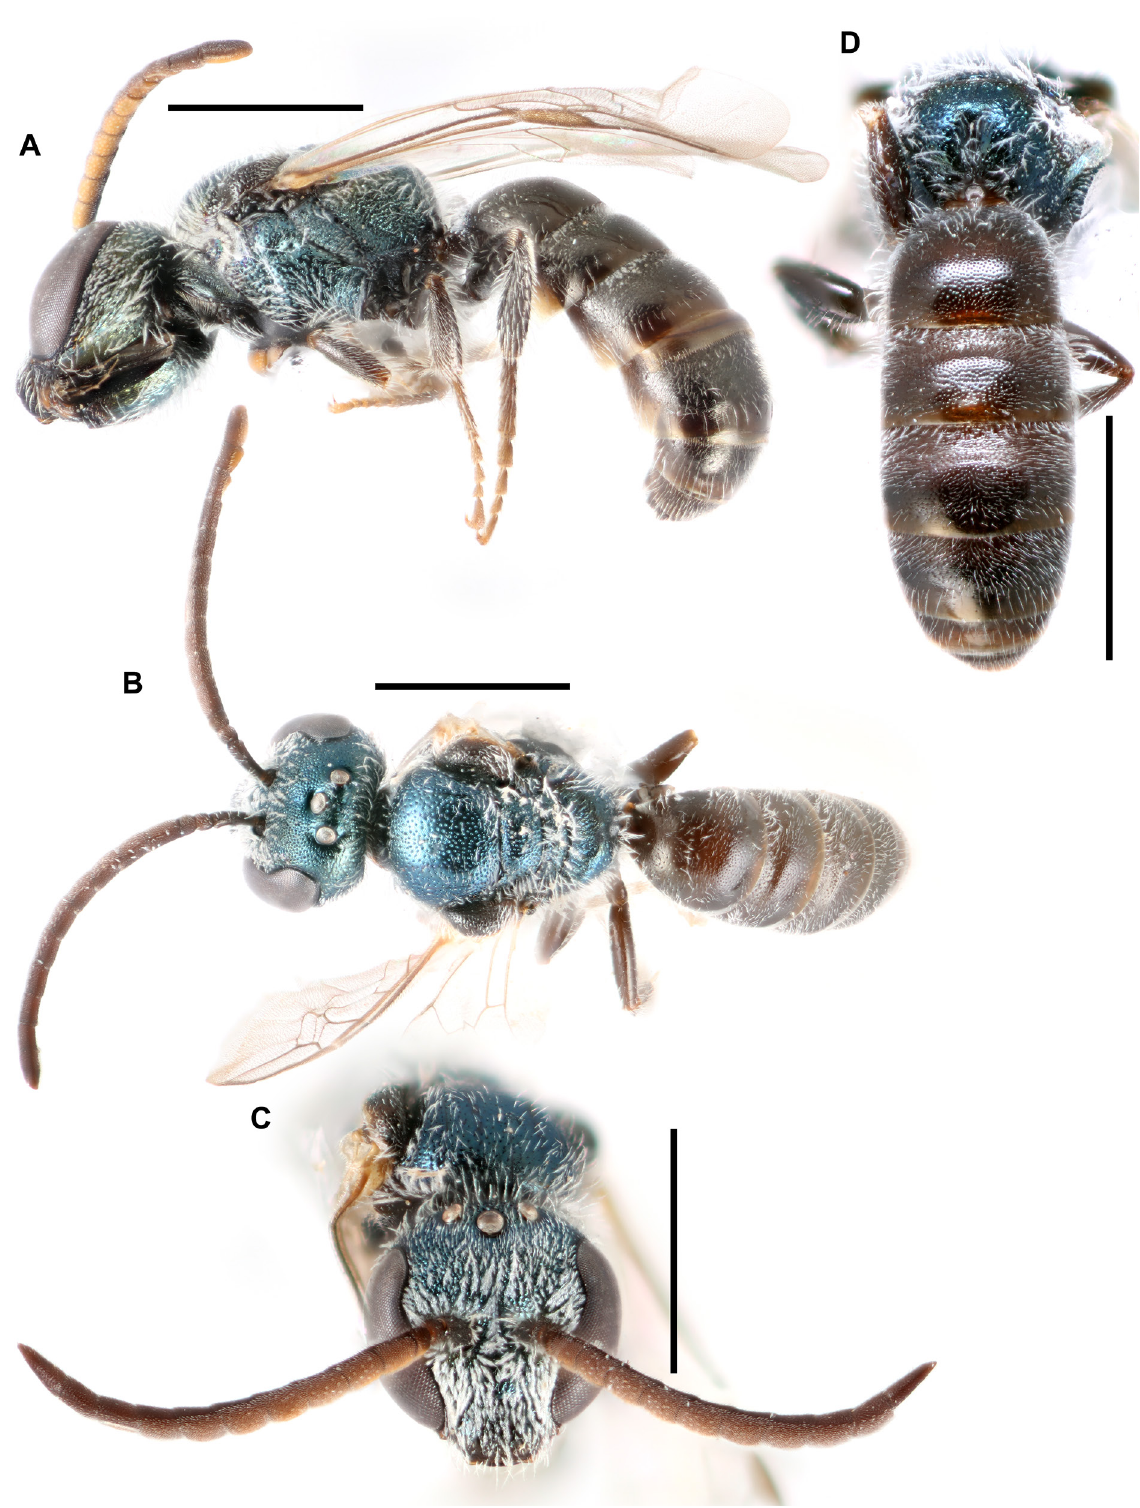
Fig. 52. Lasioglossum ( D .) pseudotegulare (Cockerell, 1896), ♂ (A =ASUHIC0112600; B–C = ASUHIC0113605; D = ASUHIC0112865). A . Lateral habitus. B . Dorsal habitus. C . Face. D . Metasoma and propodeum. Scale bars = 1